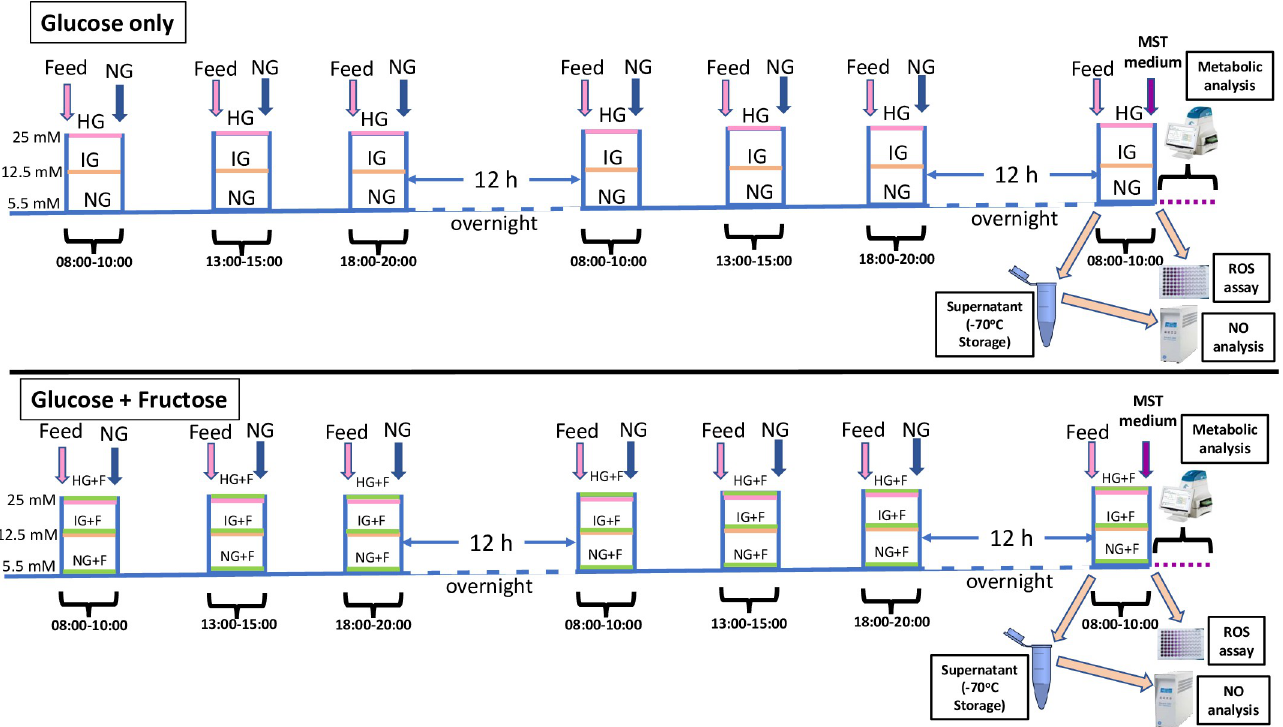
Fig 1. Representation of the experimental regimens for EA.hy926 cells (glucose only model–top panel; glucose+fructose–bottom panel). The total treatment time was 50 h, incorporating 7 treatment periods at intervals designed to mimic popular mealtimes in human populations. Two parallel sets of experiments were undertaken: cells destined for metabolic analysis were cultured in specialized 96 well microplates for this purpose; analysis was undertaken at the end of the 50 hour treatment period. Cells destined for ROS/superoxide analysis were cultured in standard 96 well microplates. Supernatant was harvested after 48 h for nitrite analysis, while ROS/superoxide analysis was conducted on the cells after the final 2 h meal exposure.